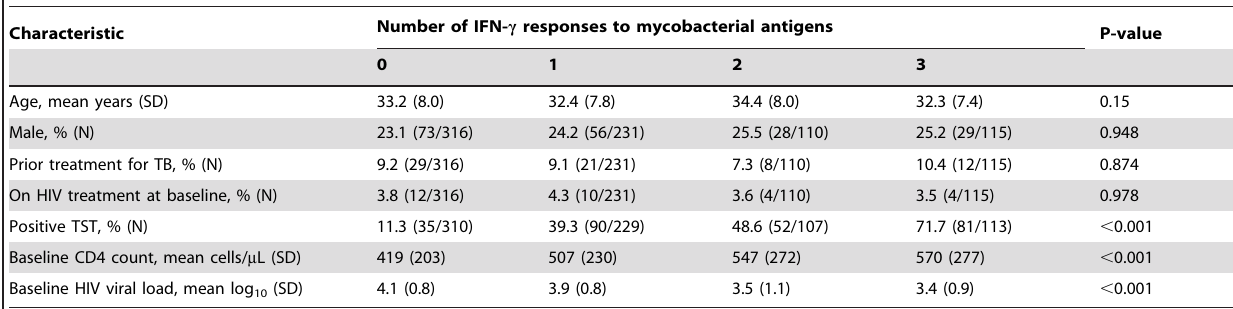
Table 2. Baseline subject characteristics according to number of detectable baseline IFN- c responses to mycobacterial antigens.